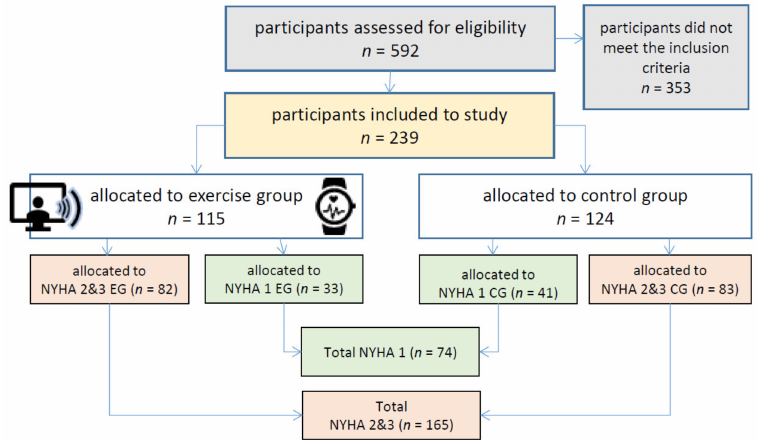
Figure 1. The course of study at baseline and randomization for the study center Hannover Medical School,